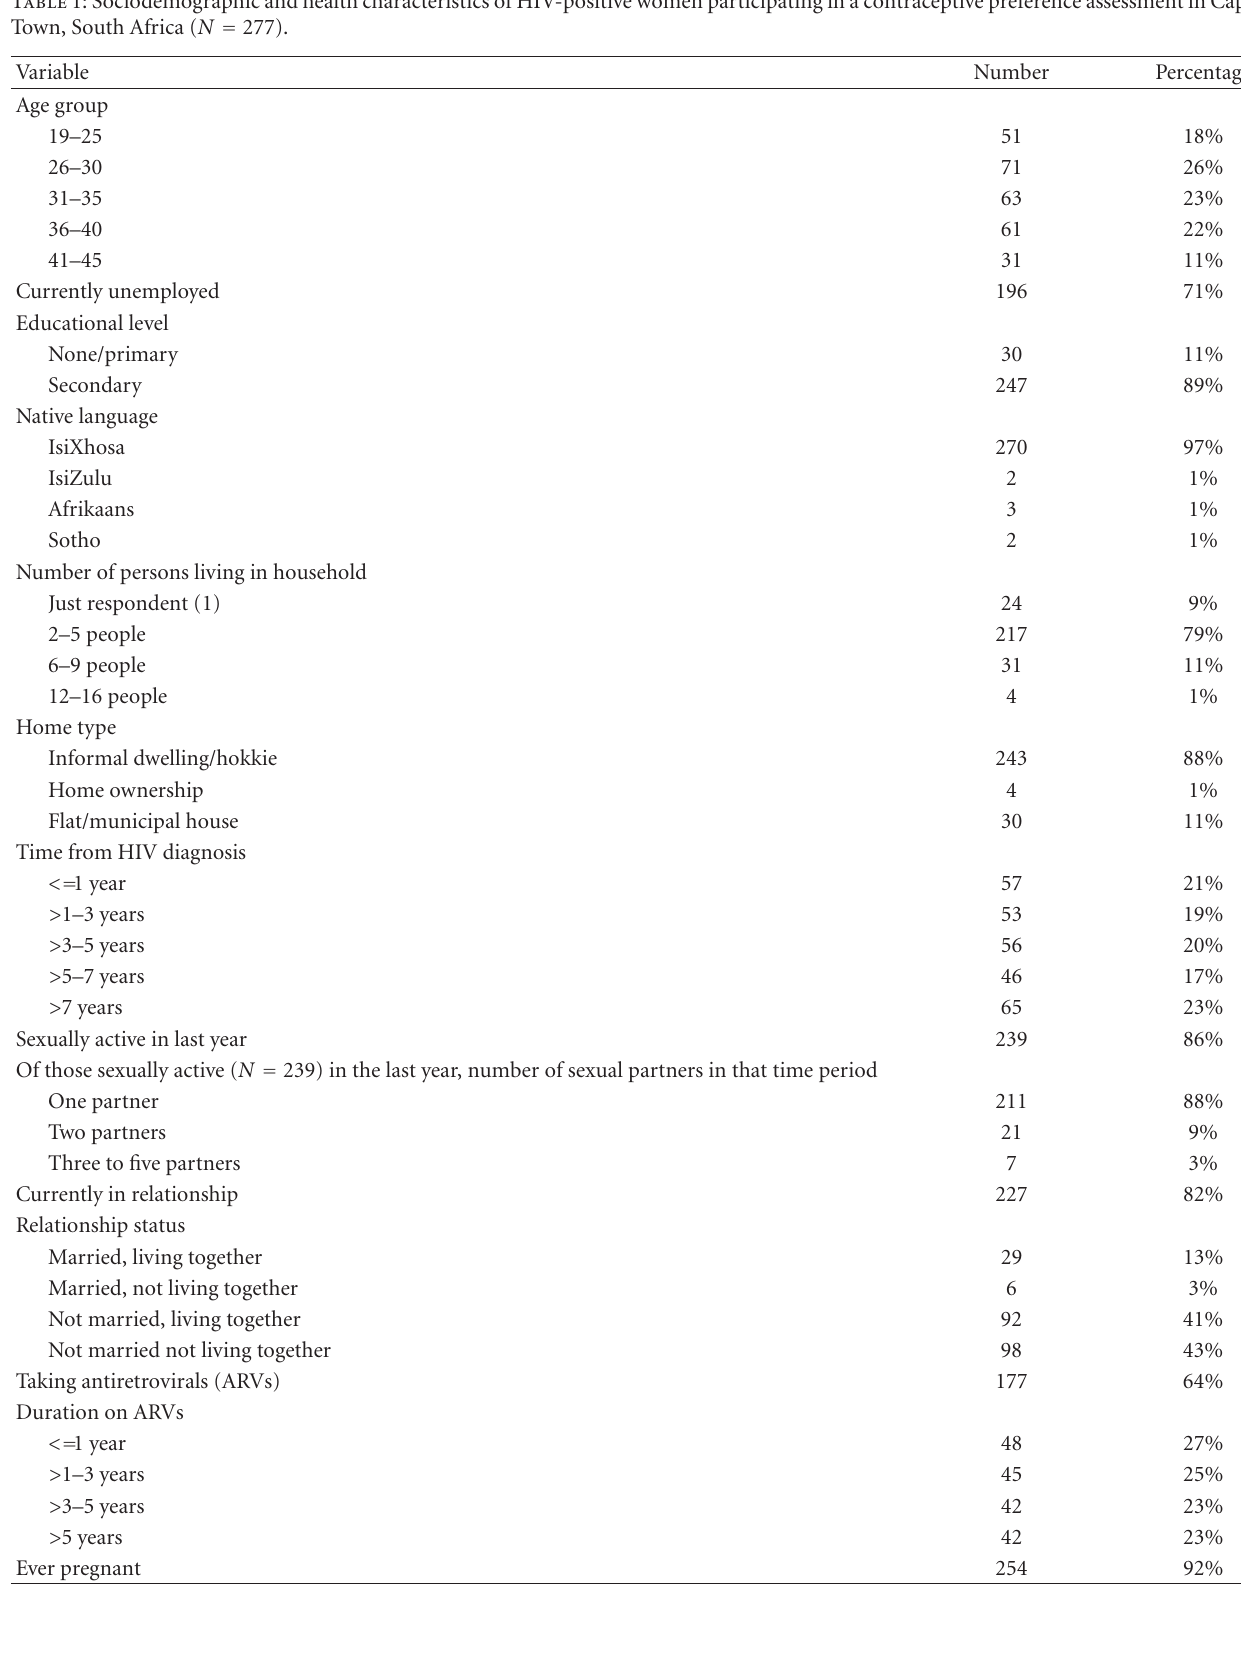
Table 1: Sociodemographic and health characteristics of HIV-positive women participating in a contraceptive preference assessment in Cape Town, South Africa ( N =